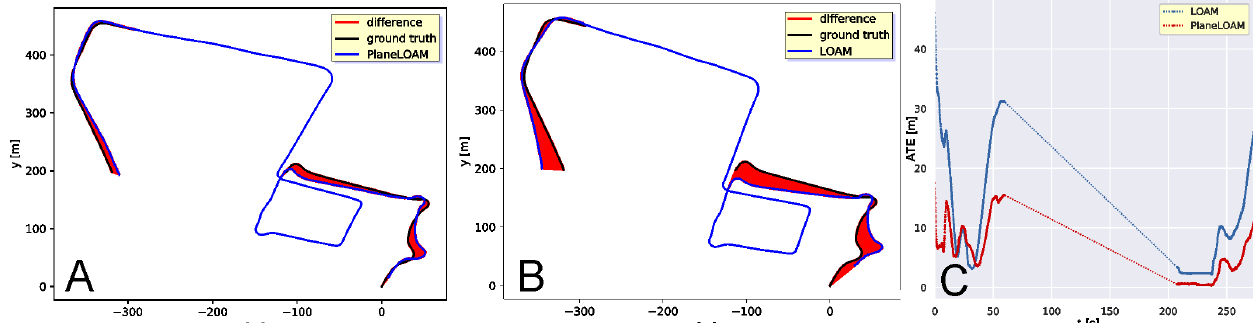
Figure 17. Results of an experiment in mixed outdoor/indoor environment of the Posnania shopping mall. The trajectories estimated by PlaneLOAM ( A ) and LOAM ( B ) were obtained from scans yielded by a Sick MRS-6124 LiDAR. Although in this experiment the ground truth DGPS trajectory was available only for the outdoor part, the plot of ATE ( C ) shows that PlaneLOAM was able to keep a much smaller drift while moving through the underground parking lot, which is an example of a highly structured environment.